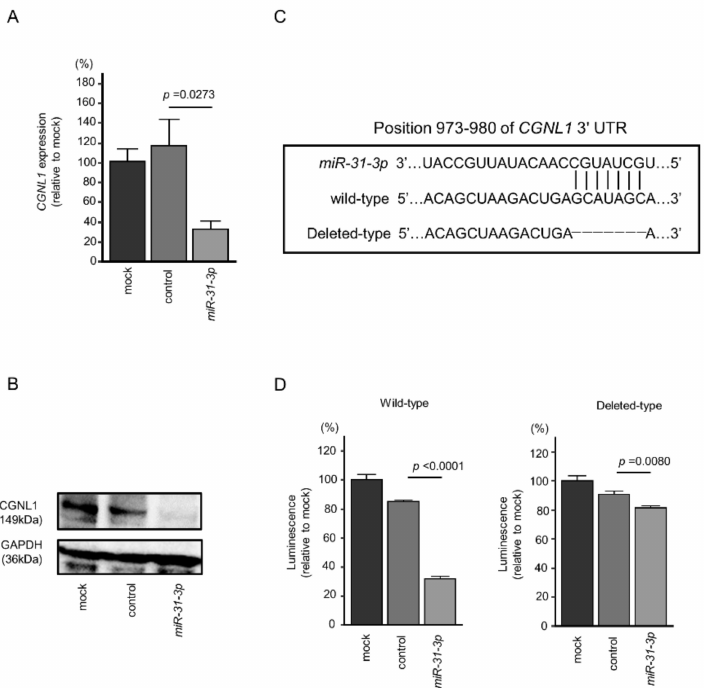
Figure 8. Expression of CGNL1 was regulated directly by miR-31-3p in HNSCC cells. ( A ) Expression of CGNL1 mRNA was significantly suppressed in miR-31-3p -transfected SAS cells (48 h after transfec- tion). ( B ) Expression of CGNL1 protein was reduced in miR-31-3p -transfected HNSCC cells (48 h after transfection). GAPDH was used as a loading control. ( C ) The Target Scan Human database predicted one putative miR-31-3p -binding site in the 3 (cid:48) -UTR of CGNL1 [14]. ( D ) Dual-luciferase reporter assays showed decreased luminescence activity in SAS cells co-transfected with miR-31-3p together with a vector harboring the “wild-type”. Normalized data were calculated as Renilla/firefly luciferase activity